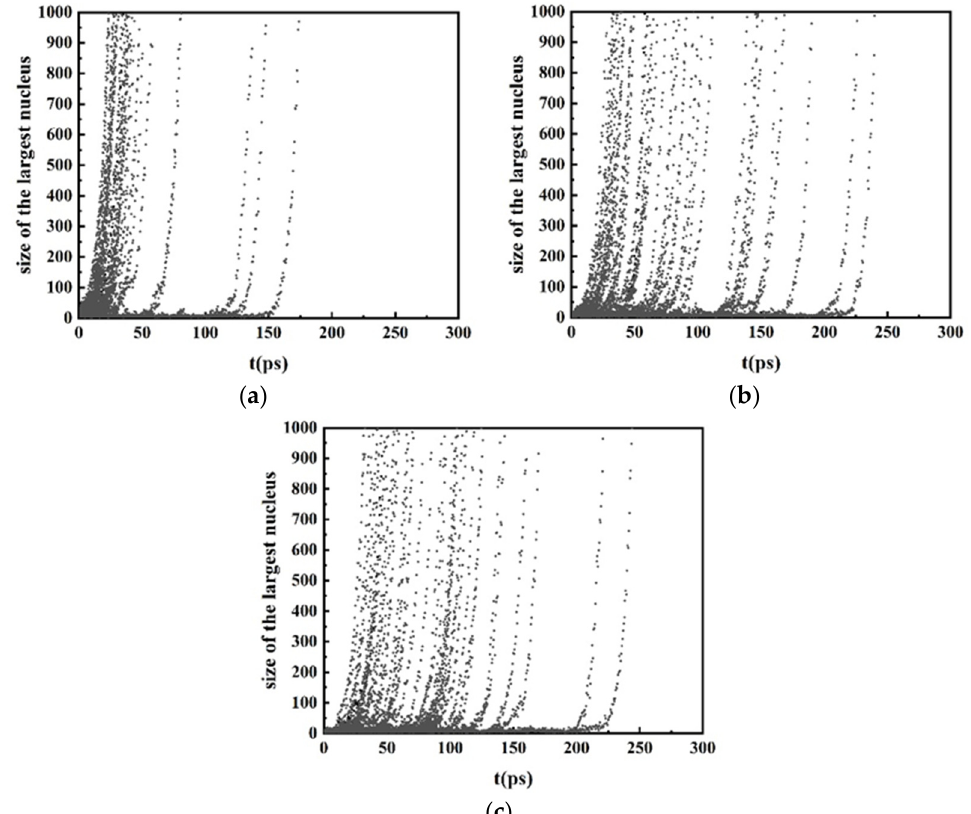
Figure 4. Evolution of the number of atoms in the largest cluster during the isothermal solidification process with different cooling rates repeatedly for 50 simulations. ( a ) 2.0 × 10 11 K/s, ( b ) 2.0 × 10 12 K/s, ( c ) 2.0 × 10 13 K/s.